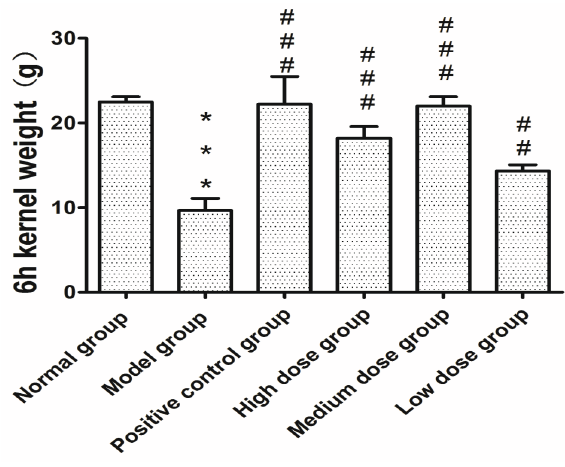
Figure 4b: The body weight of rats for 6 h. Fig. 4b The body weight of rats for 6 h